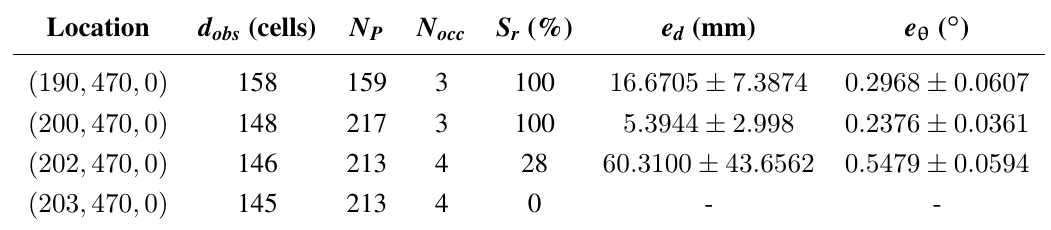
Table 6. L2-based DE-MC GL when approaching an unmodeled obstacle. Errors are the mean ± standard deviation. Sensor noise: 1%